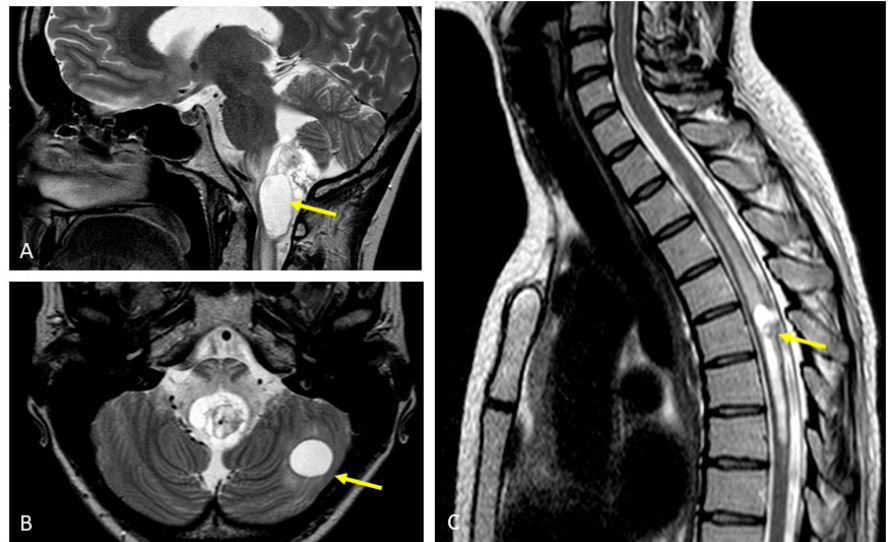
Figure 4. MRI imaging showing CNS lesions of the patient consistent with hemangioblastomas (yellow arrows): ( A ) Lesion pressing the brainstem and upper spinal cord; ( B ) Cerebellar lesion; ( C ) Spinal cord lesion.